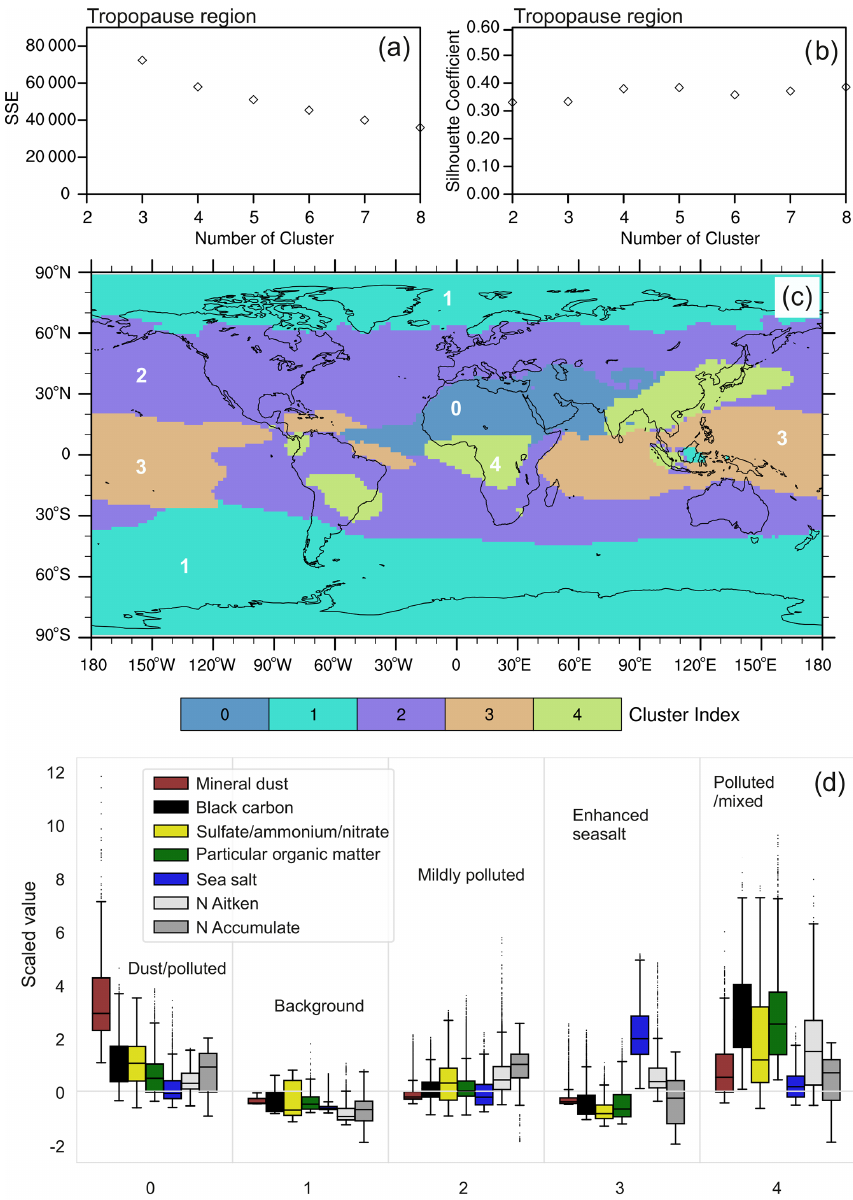
Figure 6. The same as Fig. 2 but for the tropopause region (from ∼ 300 to ∼